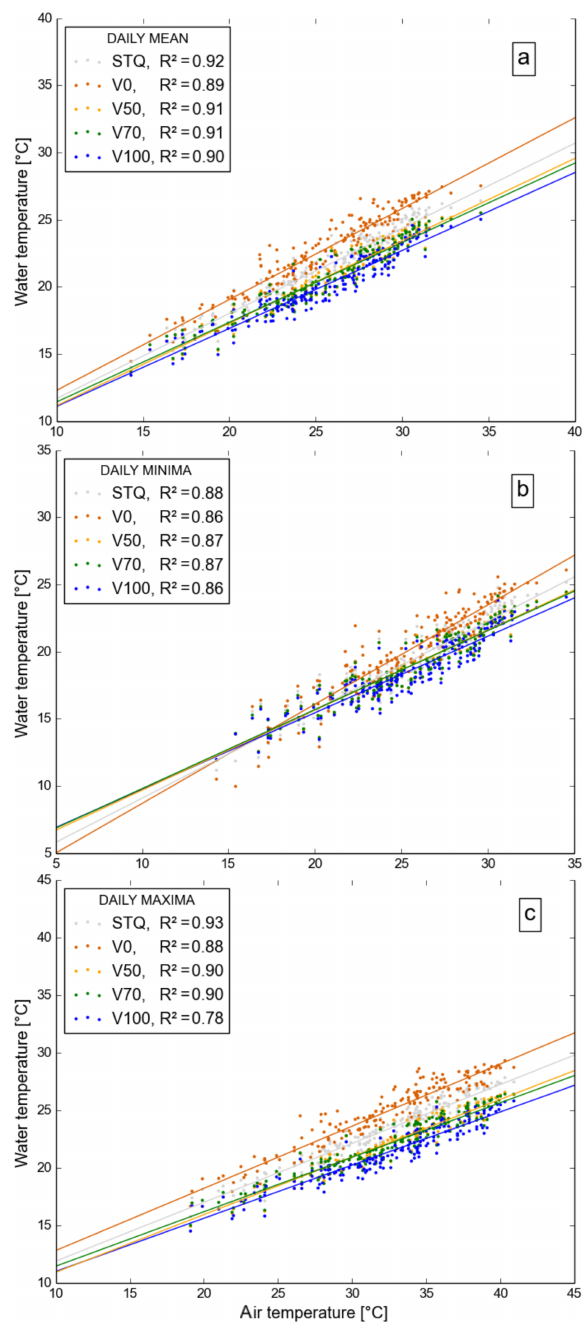
Figure 8. Correlations between water temperature and the daily (a) mean, (b) minima and (c) maxima air temperatures for the 1a, 5a, 20a and Max episodes of the climate periods centred at 2030, 2050 and 2085 for existing vegetation (STQ), no vegetation (V0), vegetation height of 50% (V50), vegetation of 70% density (V70) and full vegetation (V100) reported with the squared Spearman rank correlation coefficient. ANCOVA showed significant interactions between vegetation and air temperature ( p< 0 .